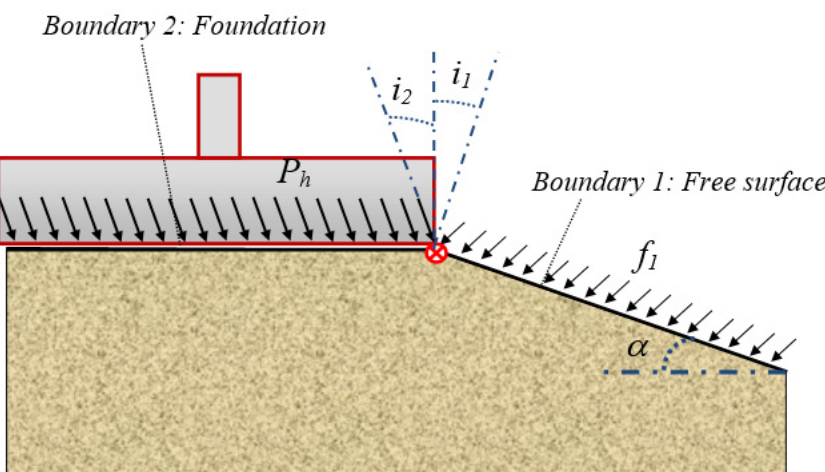
Figure 1. Mathematical model of the bearing capacity of the strip